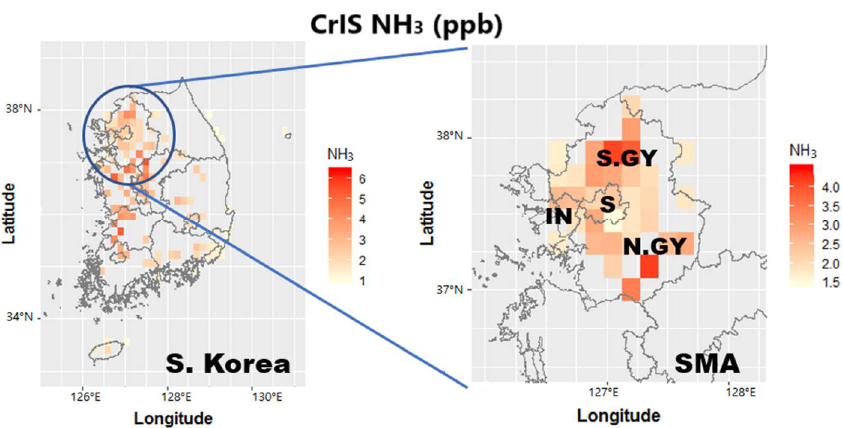
Figure 1. The average concentrations of CrIS surface level NH 3 concentration data (unit: ppb) over South Korea (2015–2017) ( left ) and the data over Seoul Metropolitan Area (SMA), which consists of Seoul (denoted as “S”), Incheon (denoted as “IN”), the northern Gyeonggi area (denoted as “N.GY”), and the southern Gyeonggi area (denoted as “S.GY”) are shown ( right ). The grid with less than 1.5 ppbv were masked out.